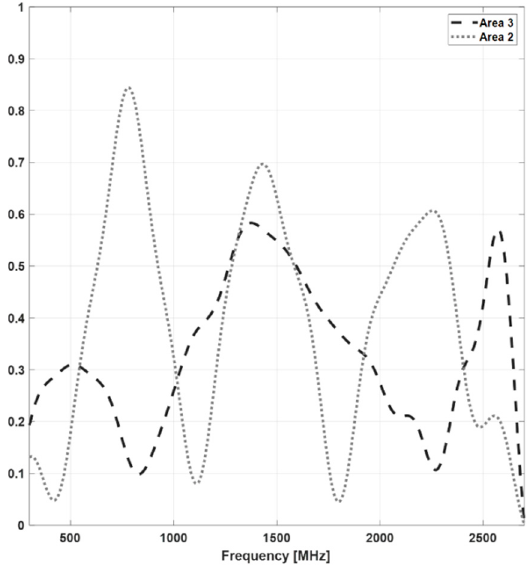
Figure 19. Amplitude variations versus frequency, comparison between Area 2 and Area 3.